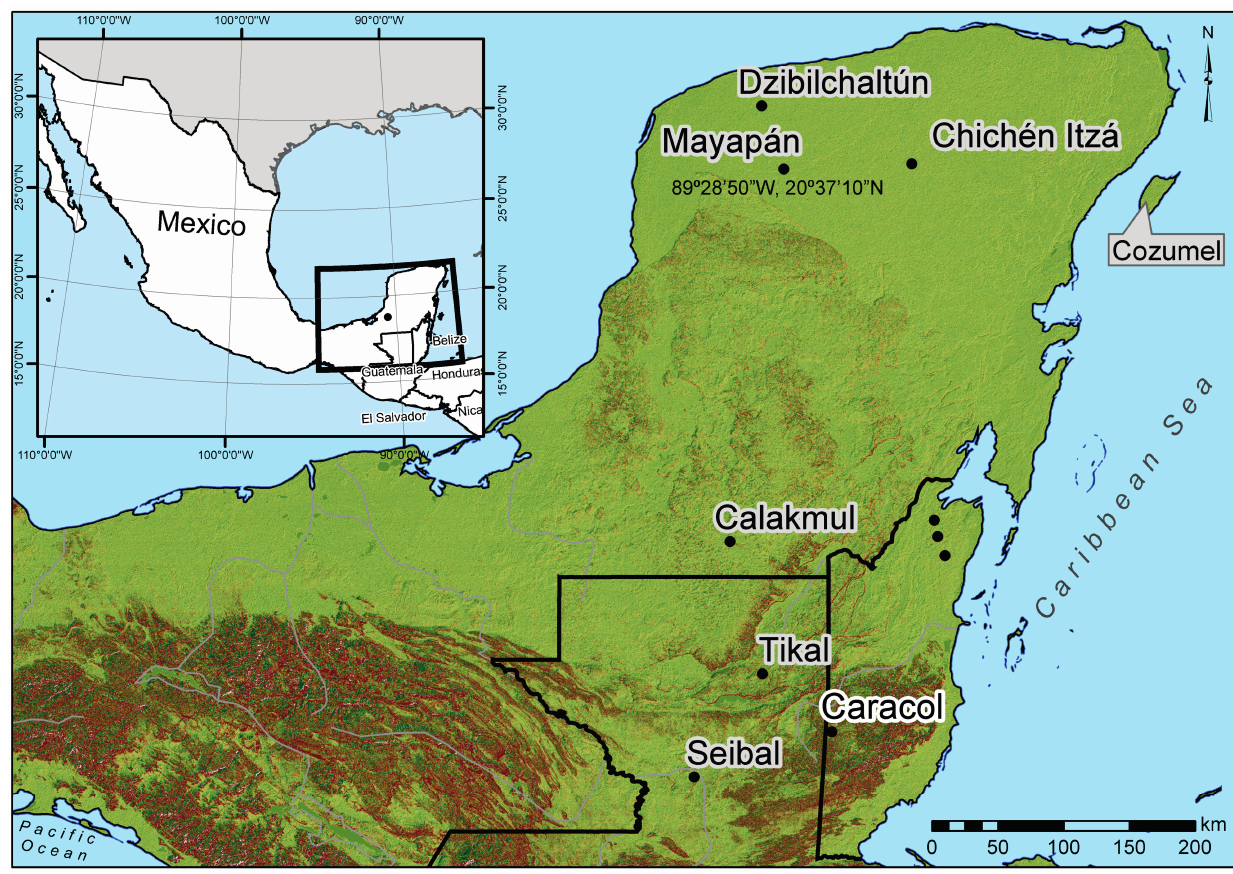
Figure 1. The location of Mayapán in